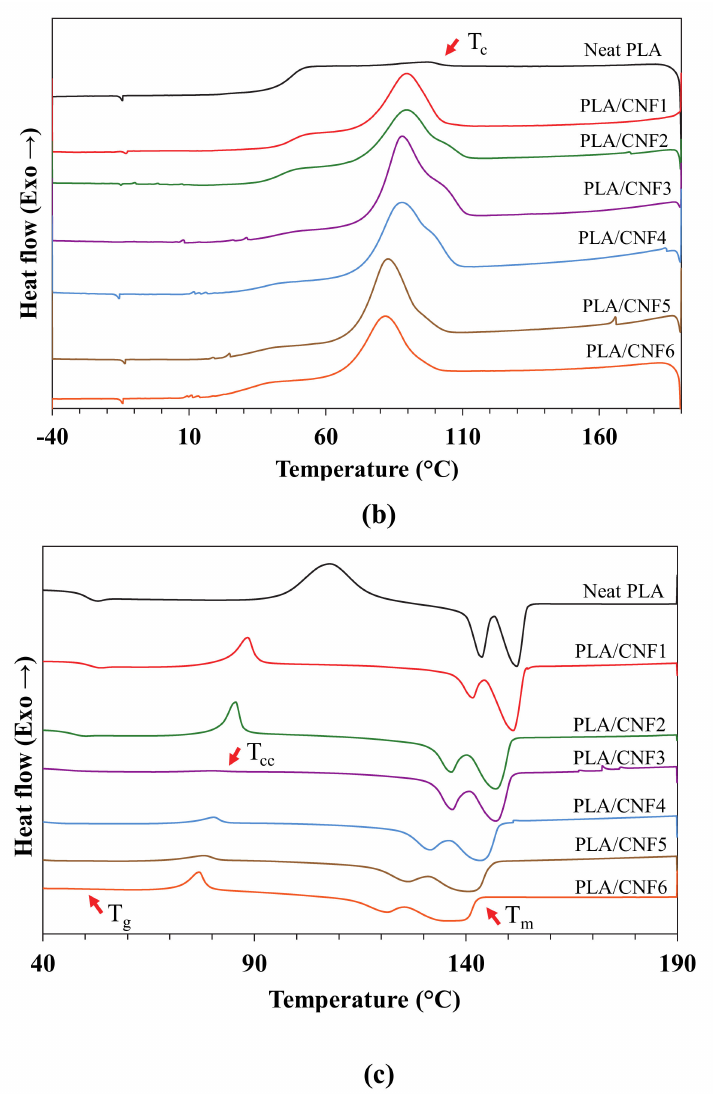
Figure 1. DSC curves at 2 ◦ C/min for neat PLA and PLA/CNF nanocomposites: ( a ) first heating scan, ( b ) cooling scan, and ( c ) subsequent heating